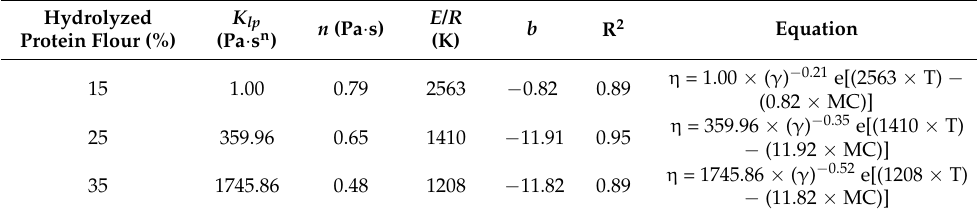
Table 8. Harper’s model parameters for hydrolyzed protein